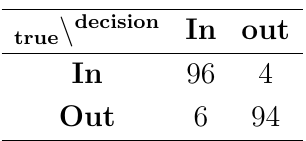
Table 5. Confusion matrix of the classes indoor and outdoor using decision trees. The values denote percentages.